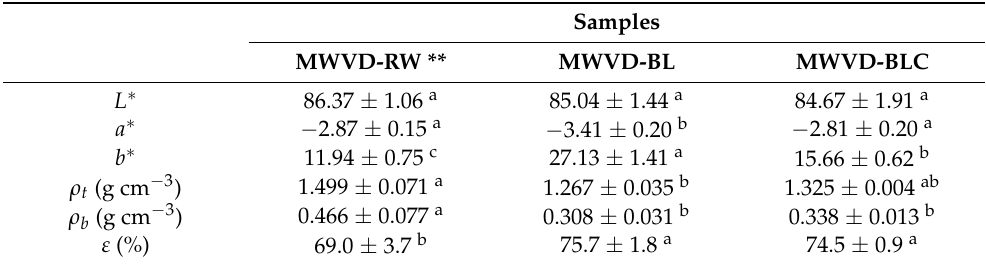
Figure 6. Digital image of dried samples MWVD-RW, MWVD-BL, and MWVD-BLC. Table 2. CIELab color parameters ( L ∗ , a ∗ , b ∗ ), true density ( ρ t ), bulk density ( ρ b ) and porosity ( ε )